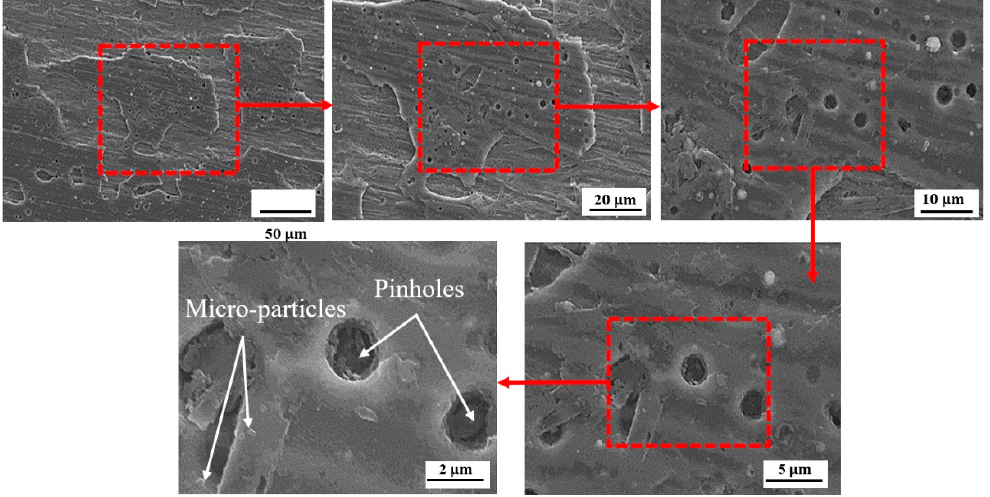
Figure 12. Surface analysis of the CrN-coated specimen following the CAE corrosion test.